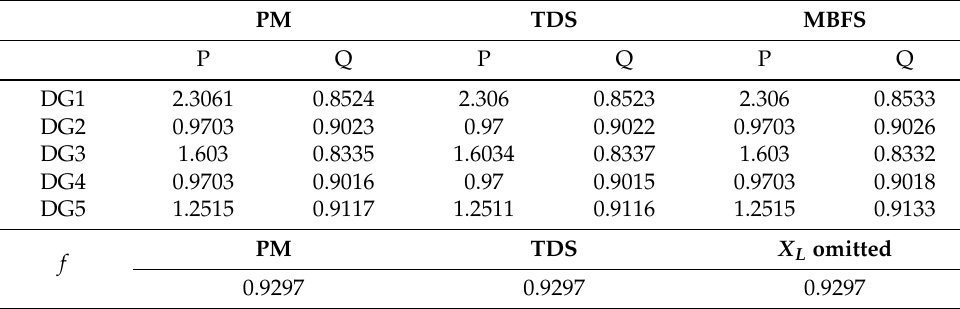
Table 4. Power and frequency for conventional droop